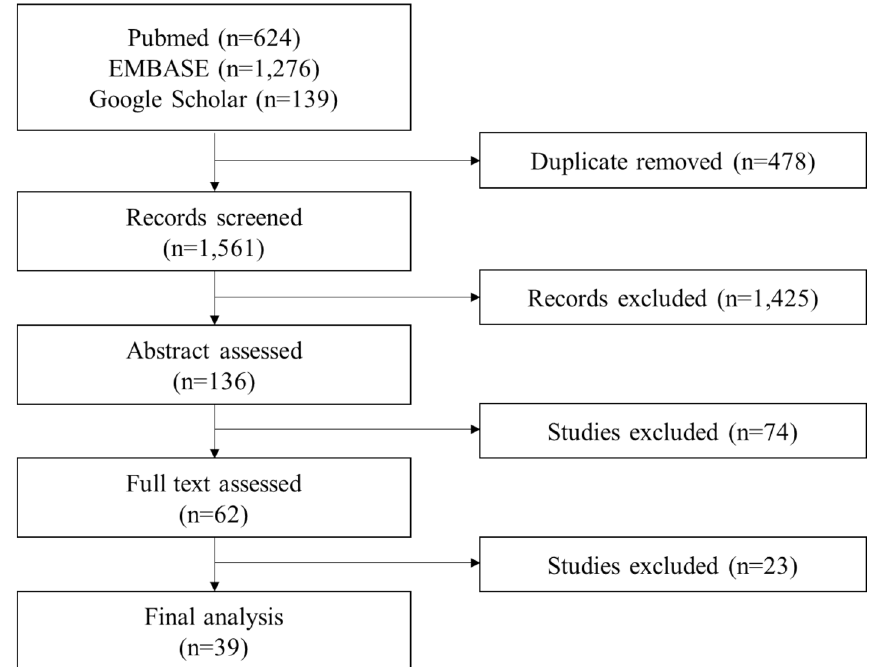
Figure 1. Flow diagram of the study selection